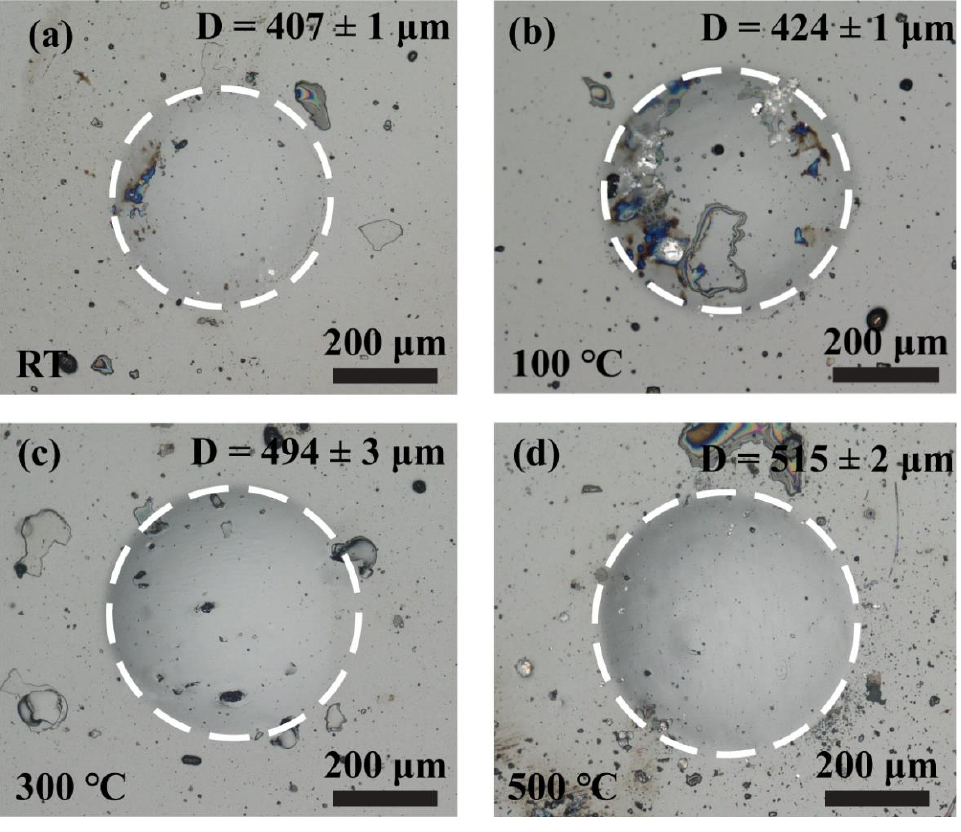
Figure 5. Surface topography of the surface topography of Cr/W-DLC/DLC multilayer films under no sand condition at ( a ) RT, ( b ) 100 °C, ( c ) 300 °C, and ( d ) 500 °C.